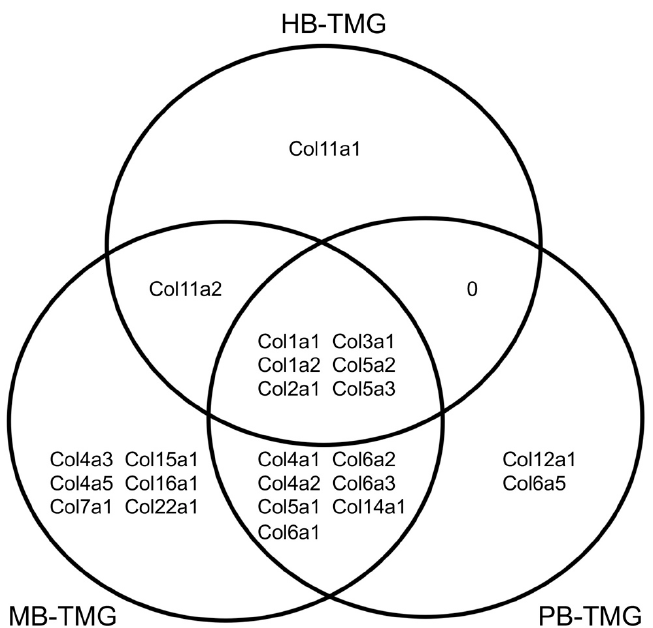
Figure 3. The common and different collagen types in HB-TMG, PB-TMG, and MB-TMG. The collagen chains in the three types of ECM hydrogels identified by LC-MS/MS were compared and clustered according to their presence or absence in the